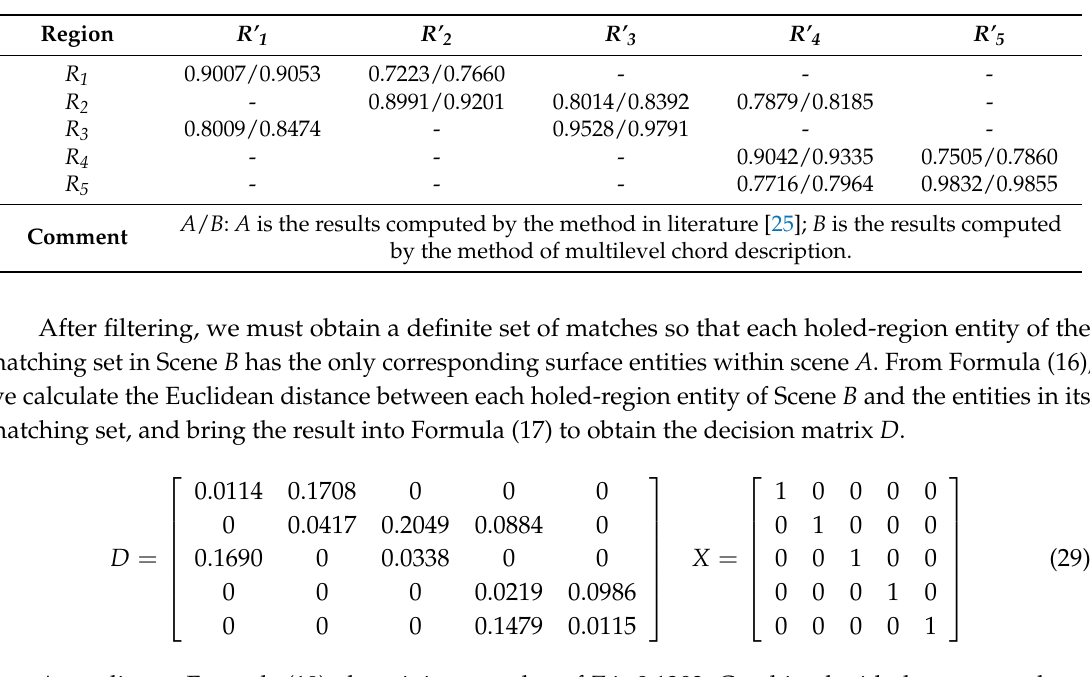
Table 6. The contour shape similarity of the matching holed-region entities after